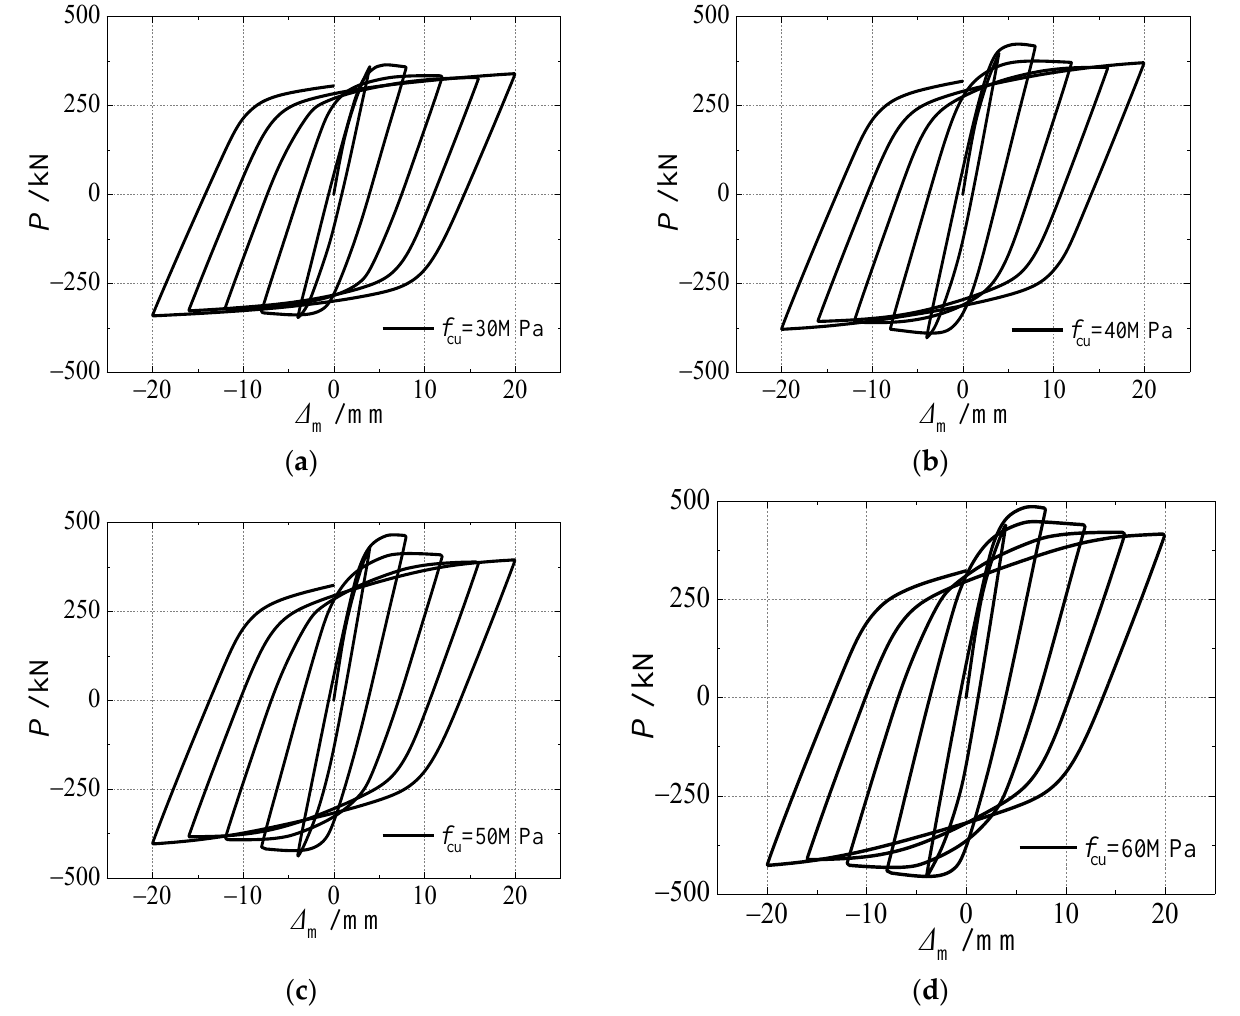
Figure 15. Effect of compressive strength of core concrete on hysteretic curve. ( a ) f cu = 30 MPa; ( b ) f cu = 40 MPa; ( c ) f cu = 50 MPa; ( d ) f cu = 60 MPa.